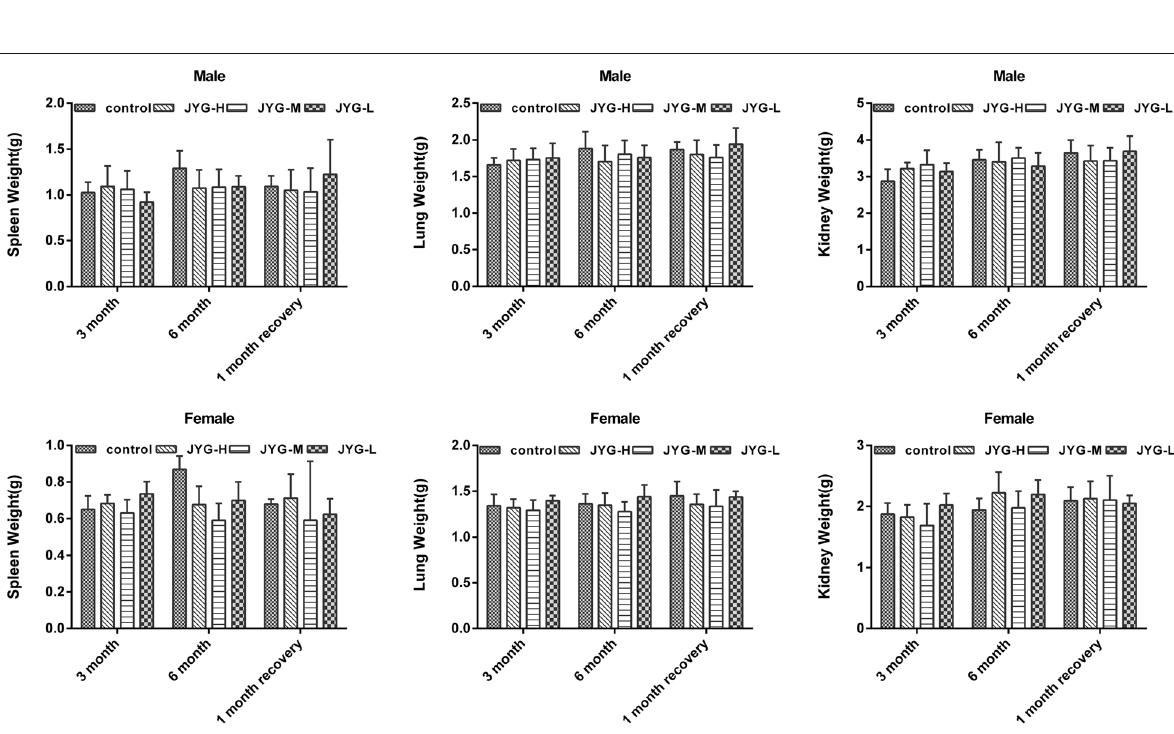
Fig. 4 Organs weight of spleen, lung, and kidney in the control and JYG-treated groups in the chronic toxicity test. Note: JYG-H, JYG-M,JYG-L: Jueyin granules high-dose, medium dose, low-dose group, respectively. The values are expressed as mean±SEM (n=10 rats for 3 months; n=17 – 19 rats for 6 months; n=10 rats for 1 month recovery). JYG-treated groups showed non-significant changes as compared with control group ( P